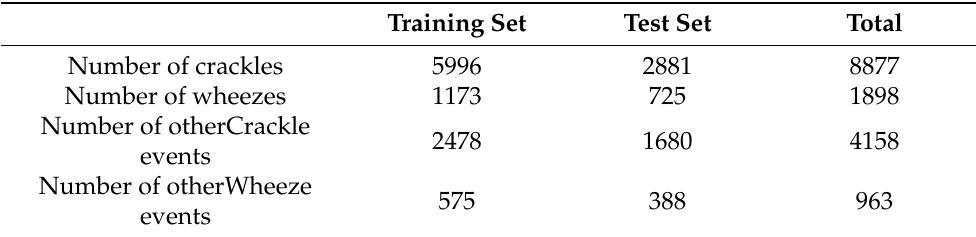
Table 4. Number of RGE with variable durations in the training and test